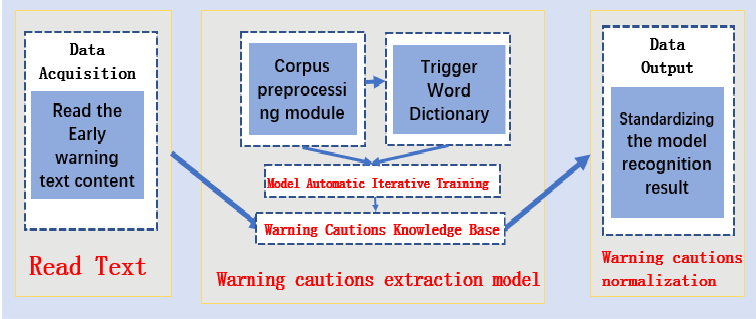
Fig. 4. Extraction process of early warning